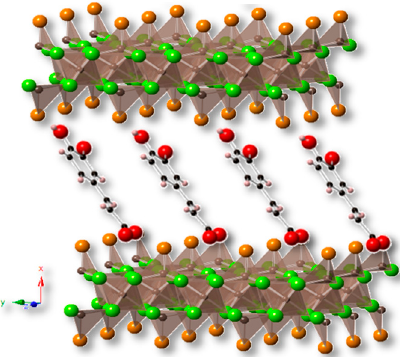
Figure 3. Representation of the caffeate anion arrangement in the interlayer space of layered structure based on ZHA and ZHN host